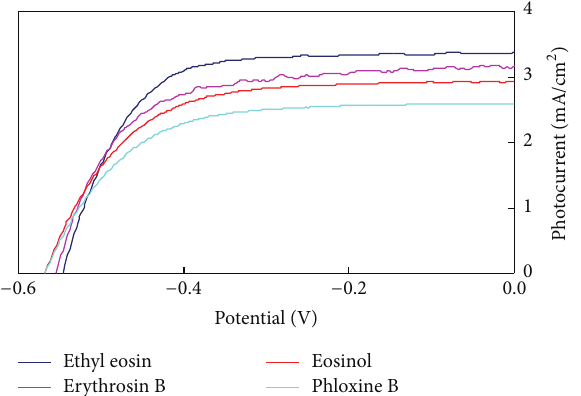
Figure 6: Photocurrent-voltage characteristics of TiO 2 electrodes sensitized with triarylmethane based dyes under illumination with 100 mW/cm 2 light intensity.